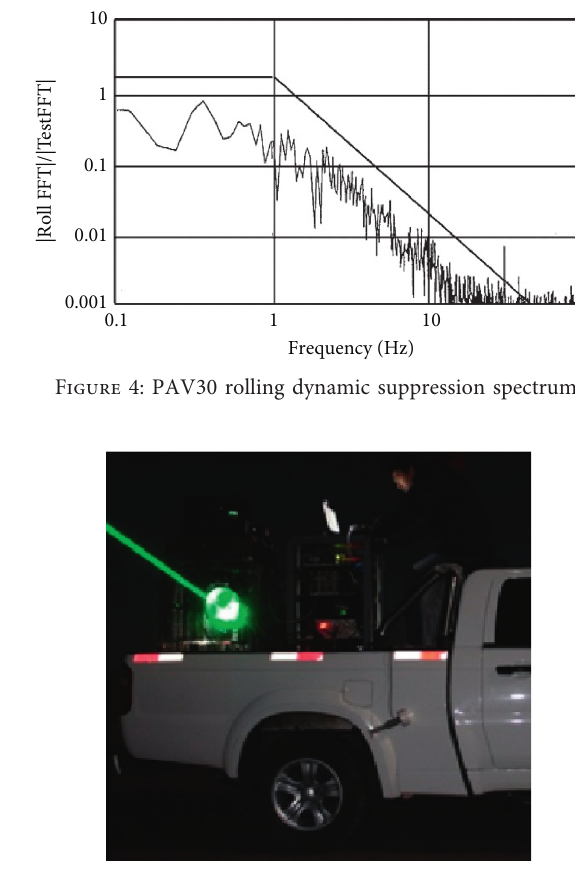
Figure 5: Car sports’ platform